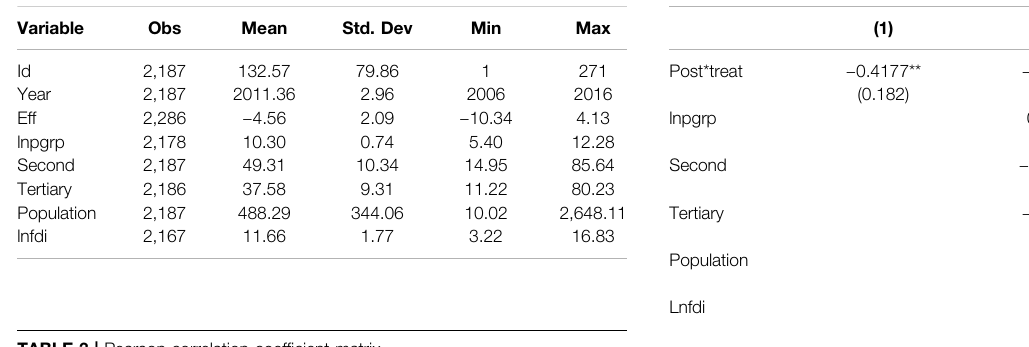
TABLE 2 | Descriptive statistical results.